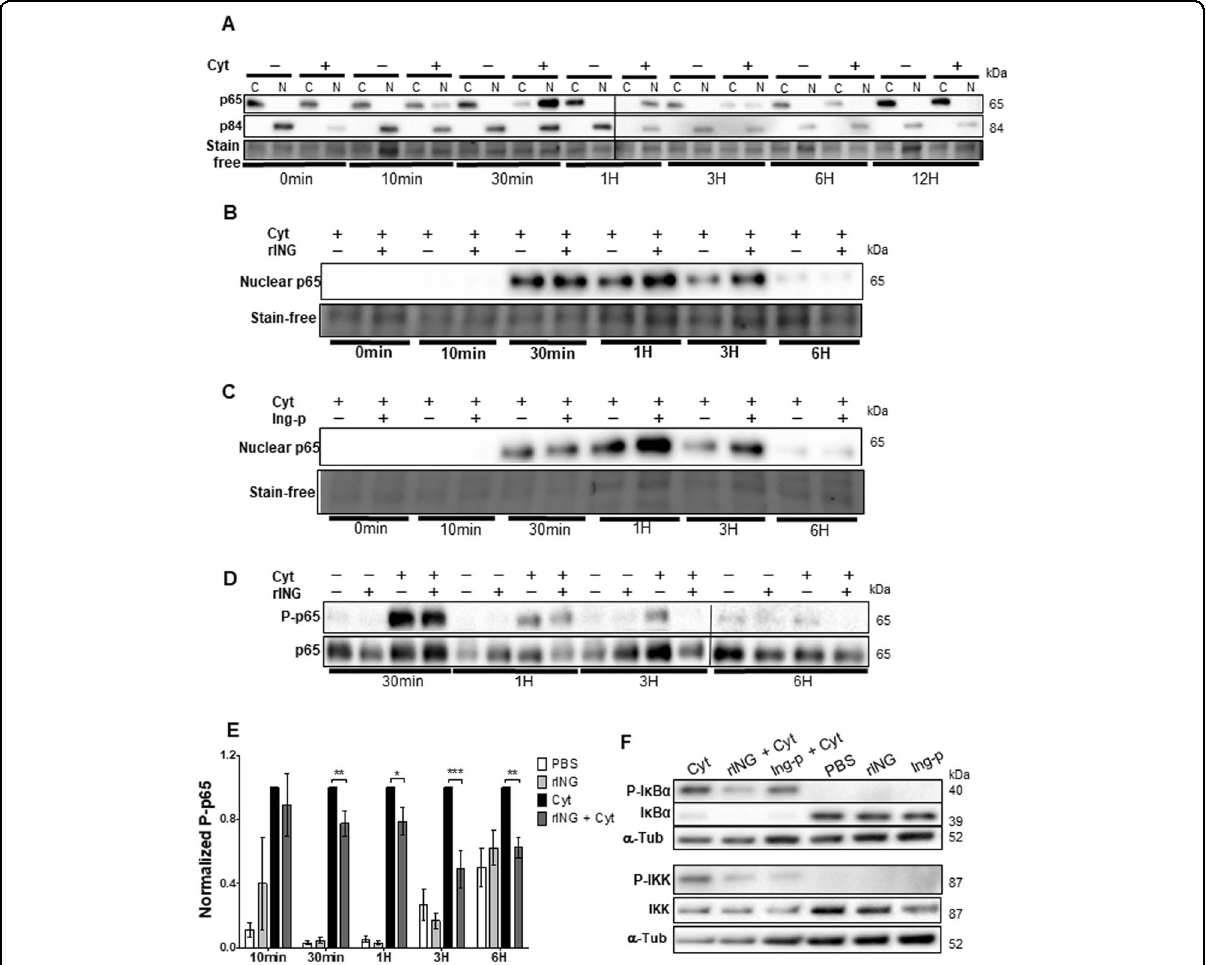
Fig. 4 Effect of INGAP pre-treatment on cytokine-induced p65 nuclear translocation and phosphorylation. RINm5F cells were treated with cytokines ± INGAP in the time-course experiments followed by extraction of cytoplasmic (C) and nuclear (N) proteins A – C or total proteins D – F and analyzed by Western blot. Shown are representative stain-free blots of subcellular lysates from cells treated with cytokines compared with A PBS; B rINGAP; and C Ingap-p. p84 was included as a loading control for nuclear fractions and total protein was used as a loading control for all samples. D p65 phosphorylation (P-p65) in cell lysates during time-course treatment of 6 h. E Densitometric analysis of each time point; values presented as P- p65 normalized to total lane protein and expressed as fold change over cytokines only. Data expressed as means ± SEM * P < 0.05, ** p < 0.01, *** p < 0.001 vs time-matched cytokine cocktail; multiple t test comparisons corrected by the Sidak – Bonferroni method. F Analysis of IKK and I κ B α phosphorylation after 1 h exposure to cytokines. Tubulin was used as a loading control. All data are representations from three independent